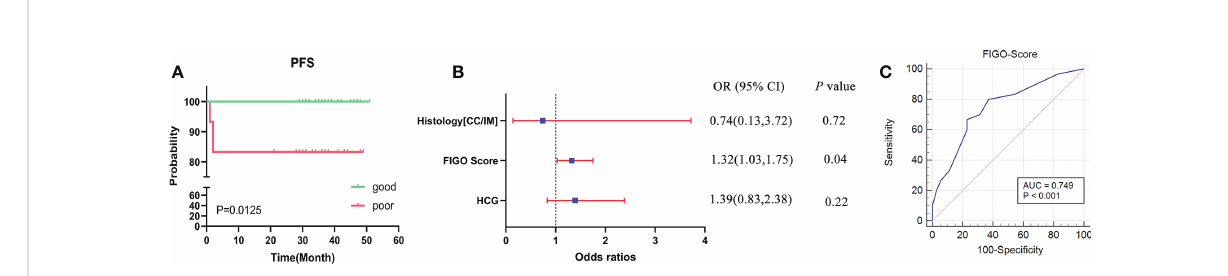
FIGURE 1 Analysis of the clinical characteristics and outcomes of patients with GTN after fi rst-line chemotherapy (A) , disease-free survival (DFS) between two groups with good or poor outcomes; (B) , multivariate regression analysis of factors associated with outcomes; (C) , ROC analysis using the FIGO risk score to discriminate between different outcome